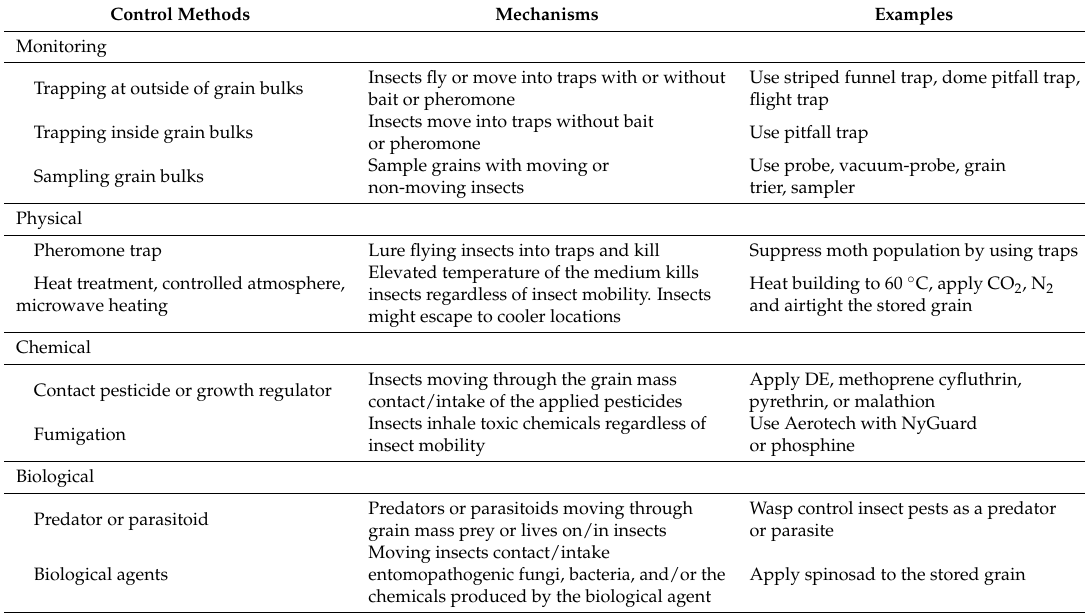
Table 1. Mechanisms of insect control methods in respect of insect movement